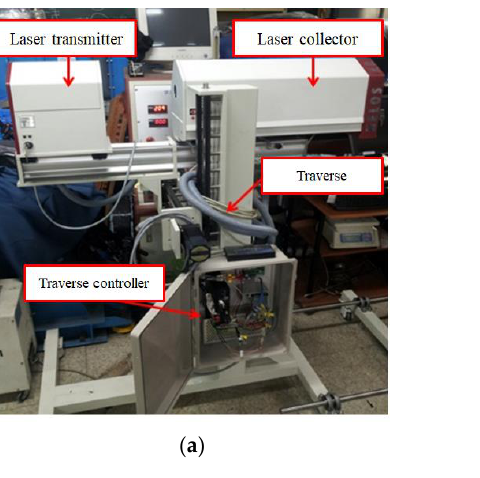
Figure 6. ( a ) Photograph of the helium – neon laser optical system (HELOS); ( b ) Schematic diagram of the HELOS and the measuring point and method.